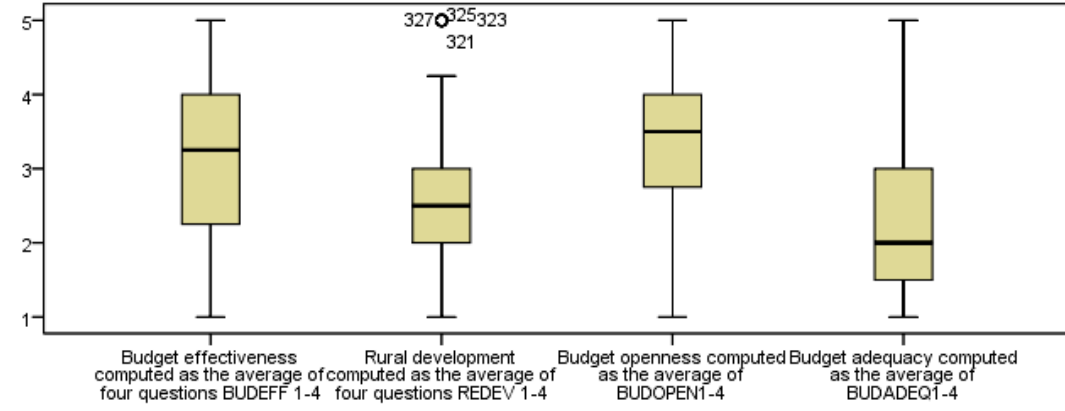
Figure 5. Box plot on outliers for characterization of the budget Table 4. Results of the multi-collinearity test